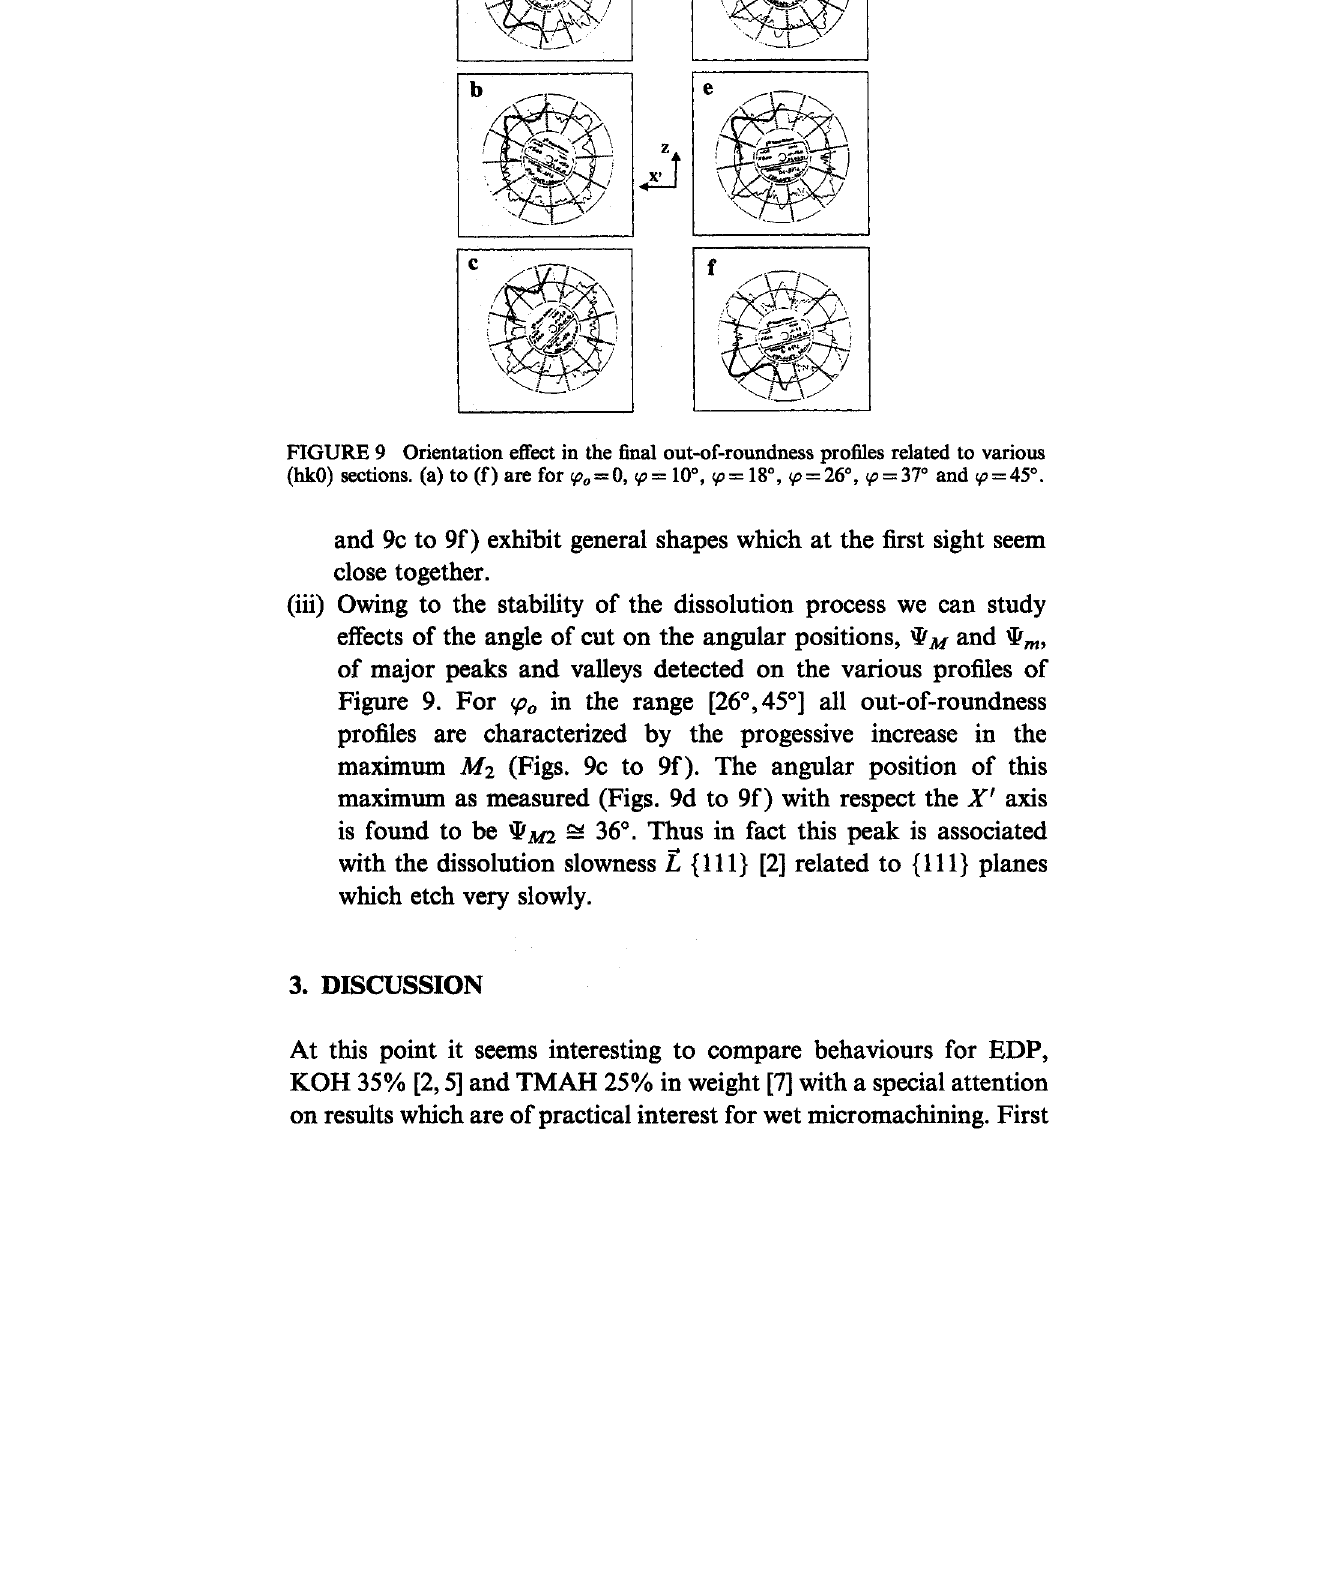
FIGURE 9 Orientation effect in the final out-of-roundness profiles related to various (hk0) sections. (a) to (f) are for o=0,